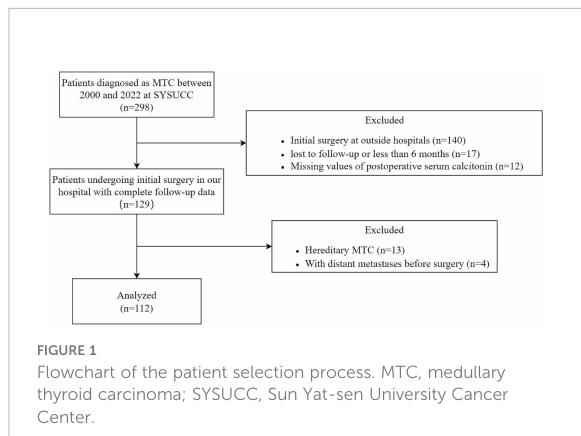
FIGURE 1 Flowchart of the patient selection process. MTC, medullary thyroid carcinoma; SYSUCC, Sun Yat-sen University Cancer